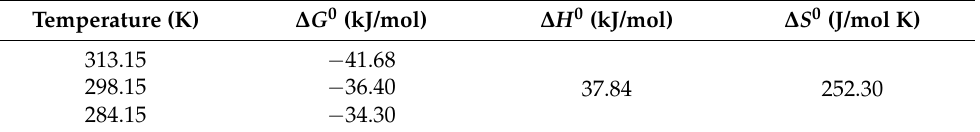
Table 5. The thermodynamic parameters of adsorption of MV onto HNC.